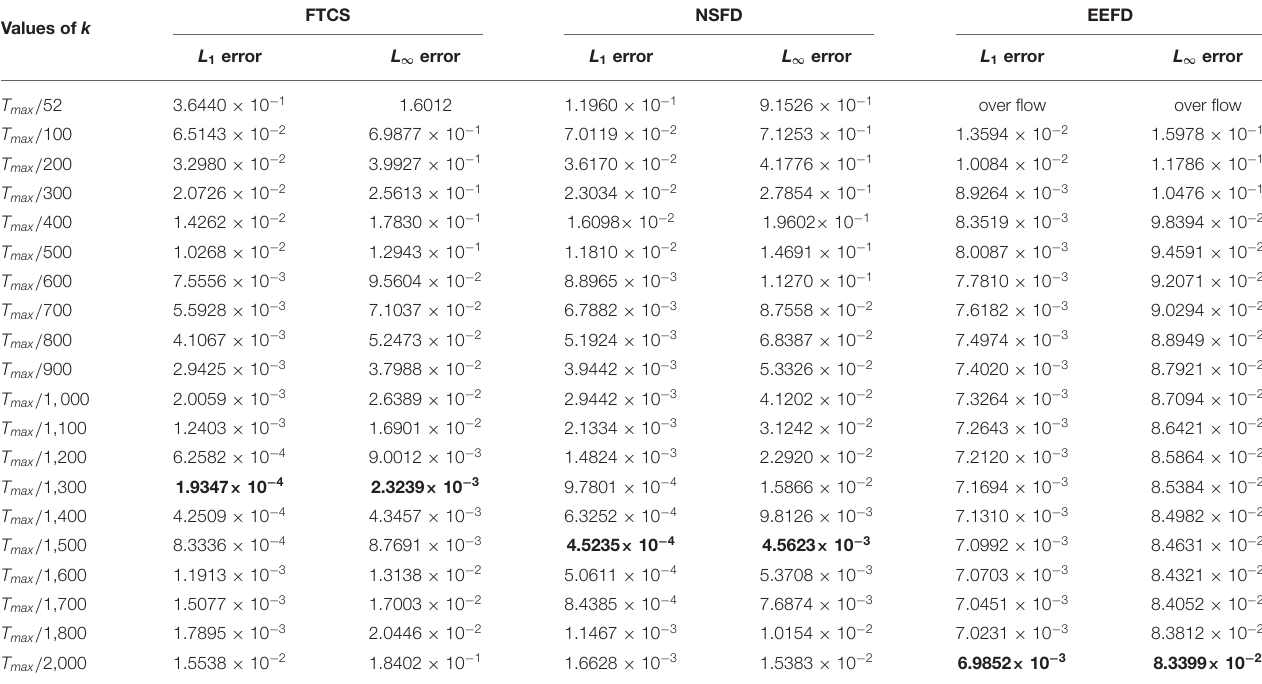
0.01 using three methods. =